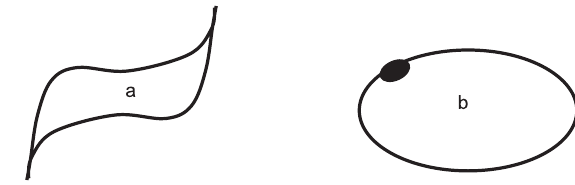
Fig. 12 Examples for particle shapes which cause photopho- retic torque. ( a ) The “Spitzenradiometer” (Hettner, 1924). The points dissipate more thermal energy and are thus colder. Due to the temperature difference, a counterclockwise torque arises. ( b ) A particle with an impurity on the surface having a different accommo- dation coefficient. Both a torque and a Δ α force